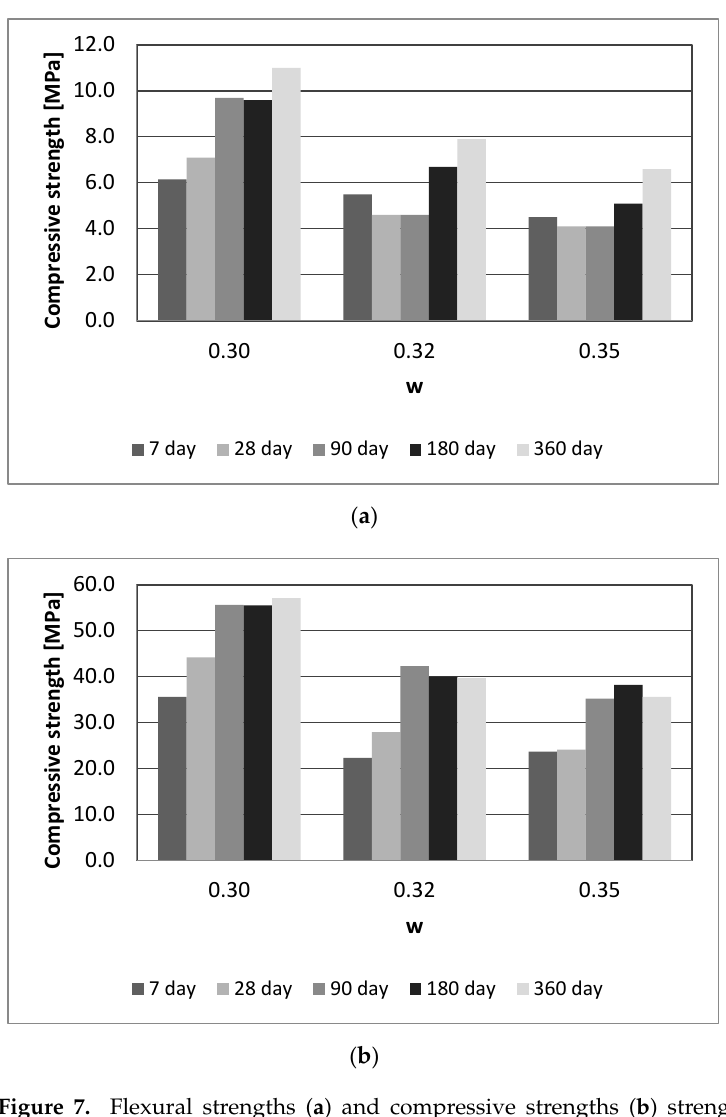
Figure 7. Flexural strengths ( a ) and compressive strengths ( b ) strength results with different HDFS/water ratios in the mixture.